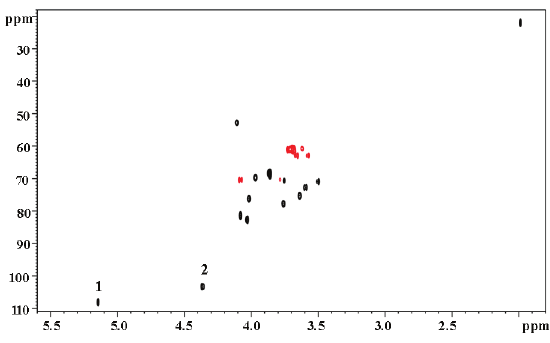
Figure 3 - 1 H- 13 C HSQC spectrum of the disaccharide al- ditol from epimatigotes of T. cruzi strain Silvio X10/1 (CH red). 1. Gal f -β-1-4-GlcNAc-ol; 2. Gal p -β-1-6- black, CH 2 GlcNAc-ol.